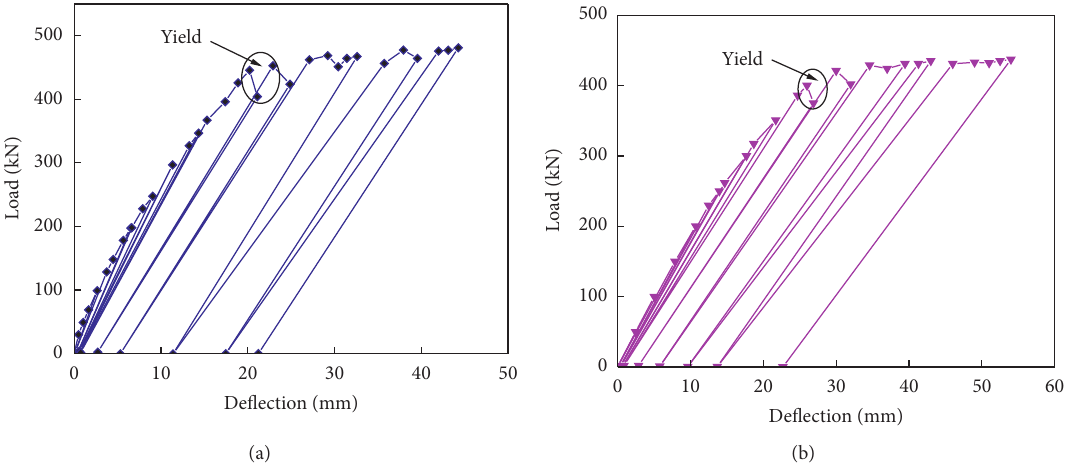
Figure 9: Load-deflection curves: (a) JD1; (b) JD2.